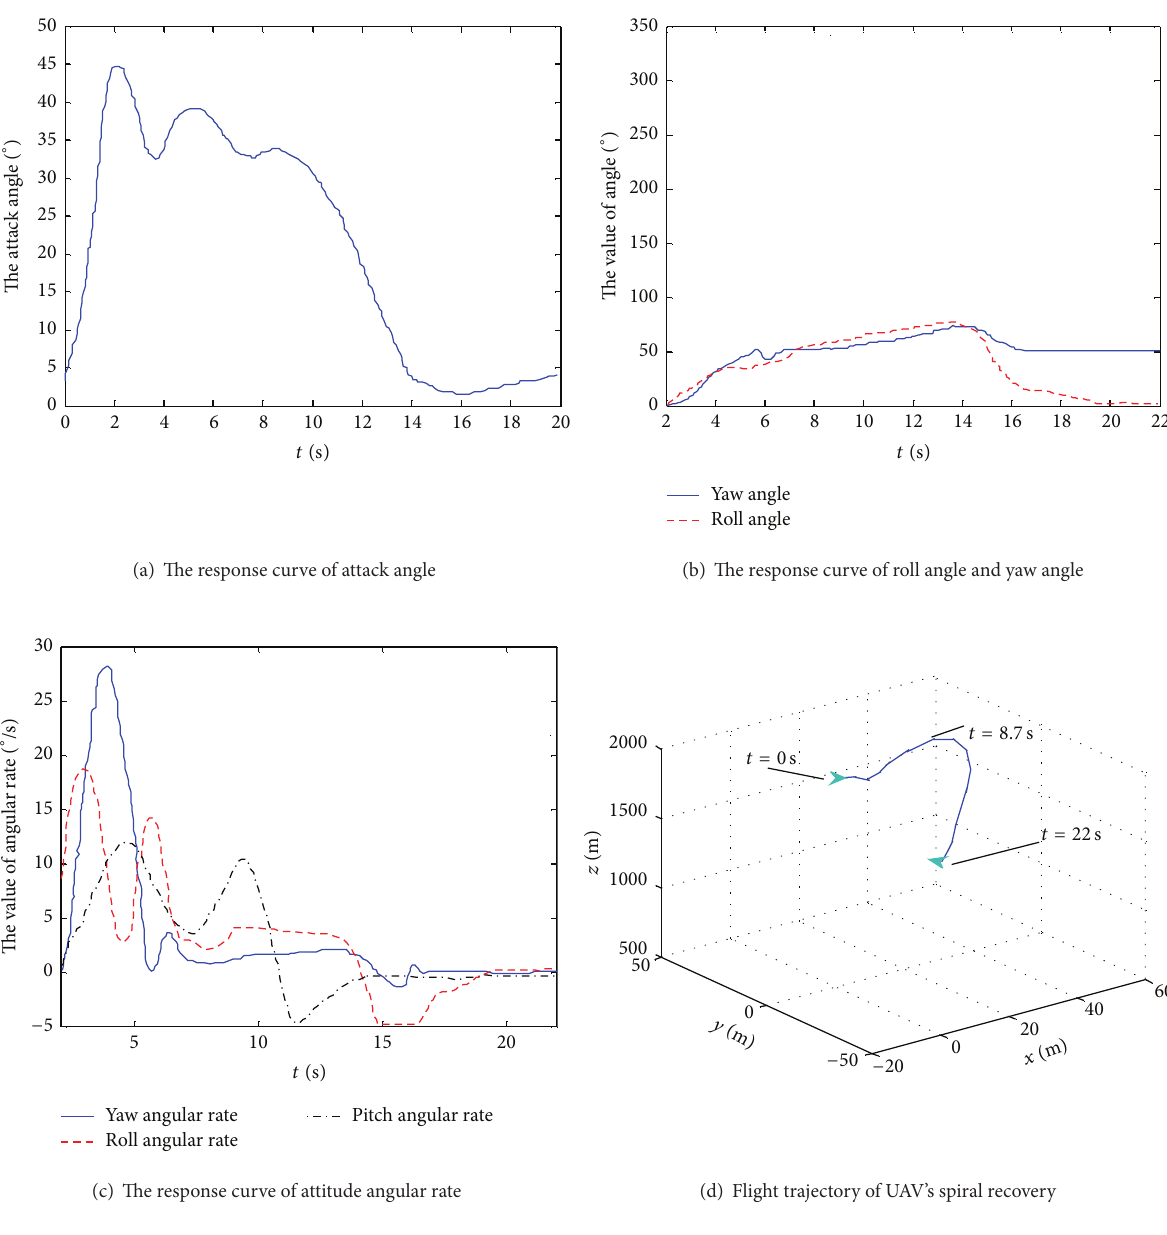
Figure 6: The dynamic process of UAV’s spiral recovery.